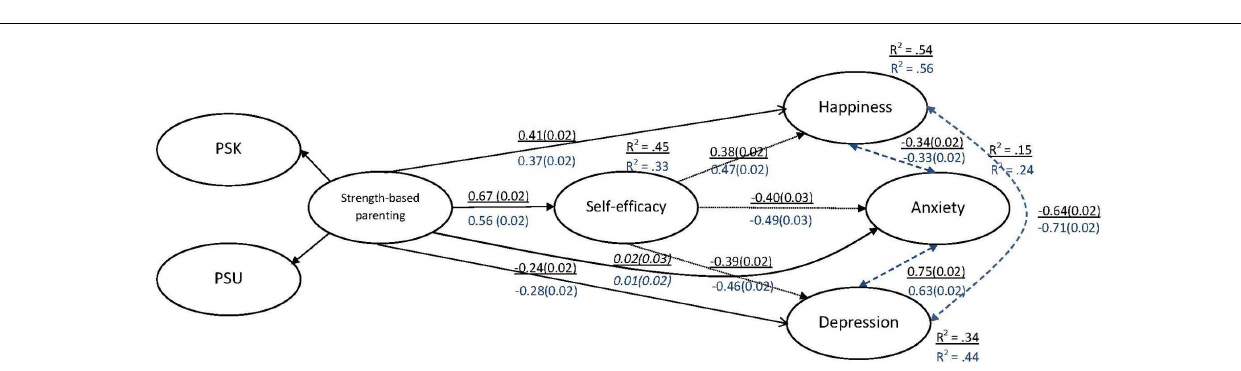
χ 2 (225) = 2292.104, p < 0.001, CFI = 0.981, RMSEA = 0.041, SRMR = 0.027, (cid:49) χ 2 (11) = 90.412, p <